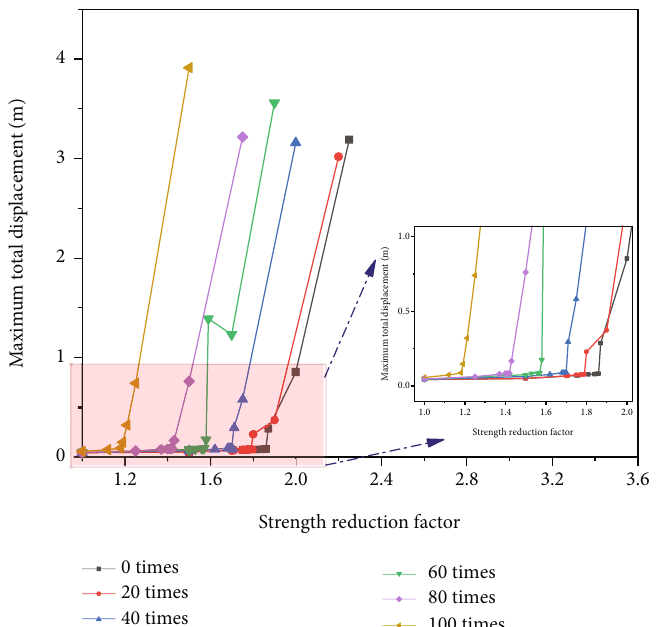
Figure 16: Relationship between strength reduction factor and maximum total displacement of slope under di ff erent times of the freeze- thaw cycle.